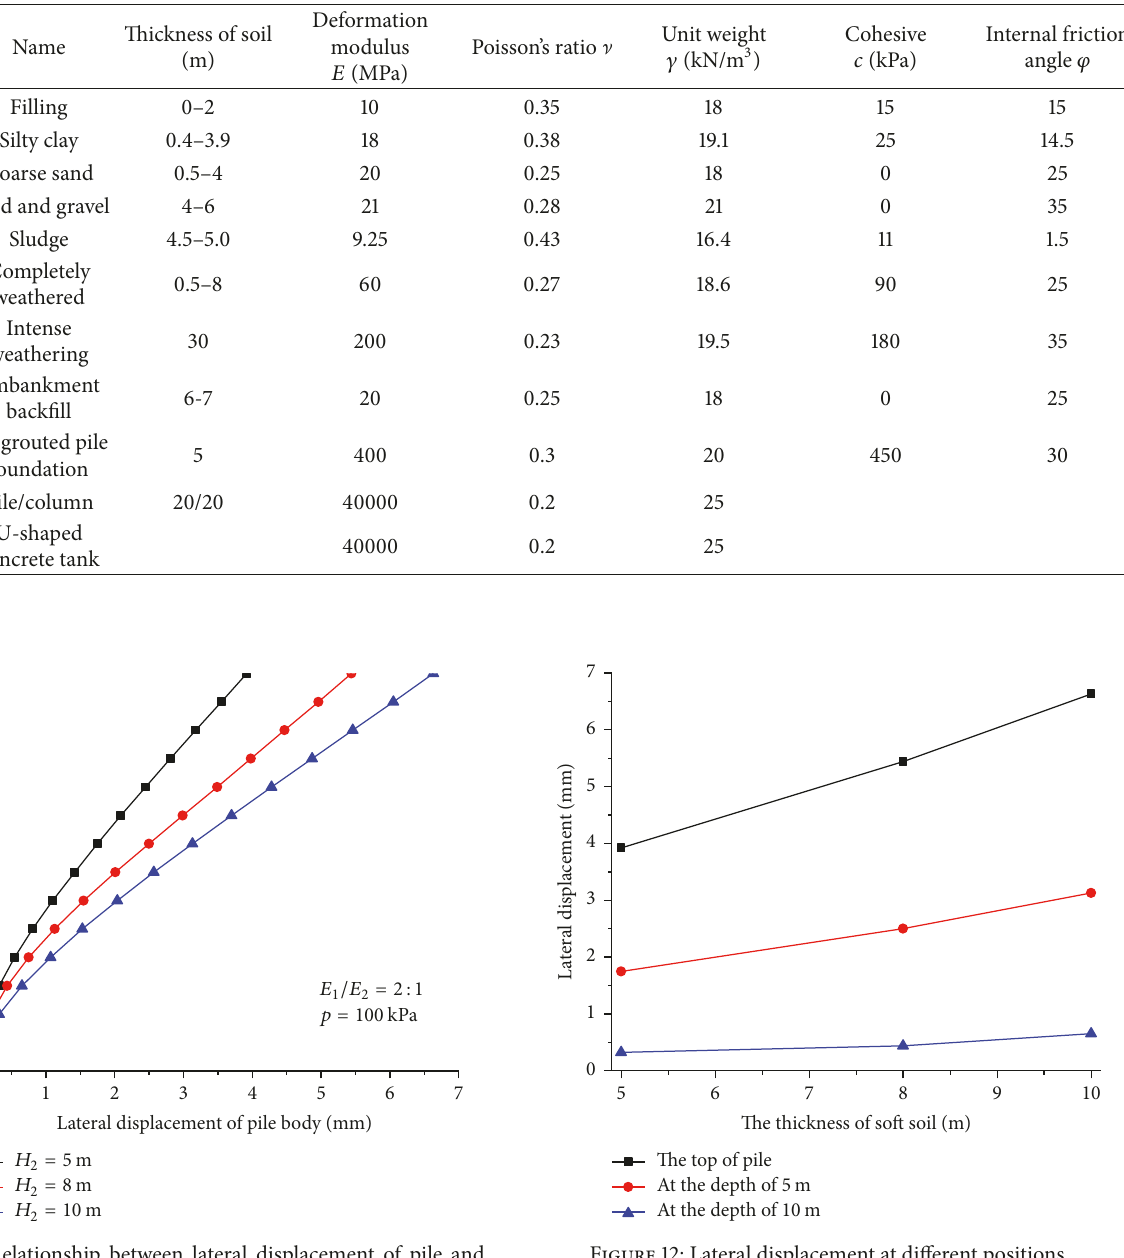
Figure 11: Relationship between lateral displacement of pile and relative thickness of soft soil.